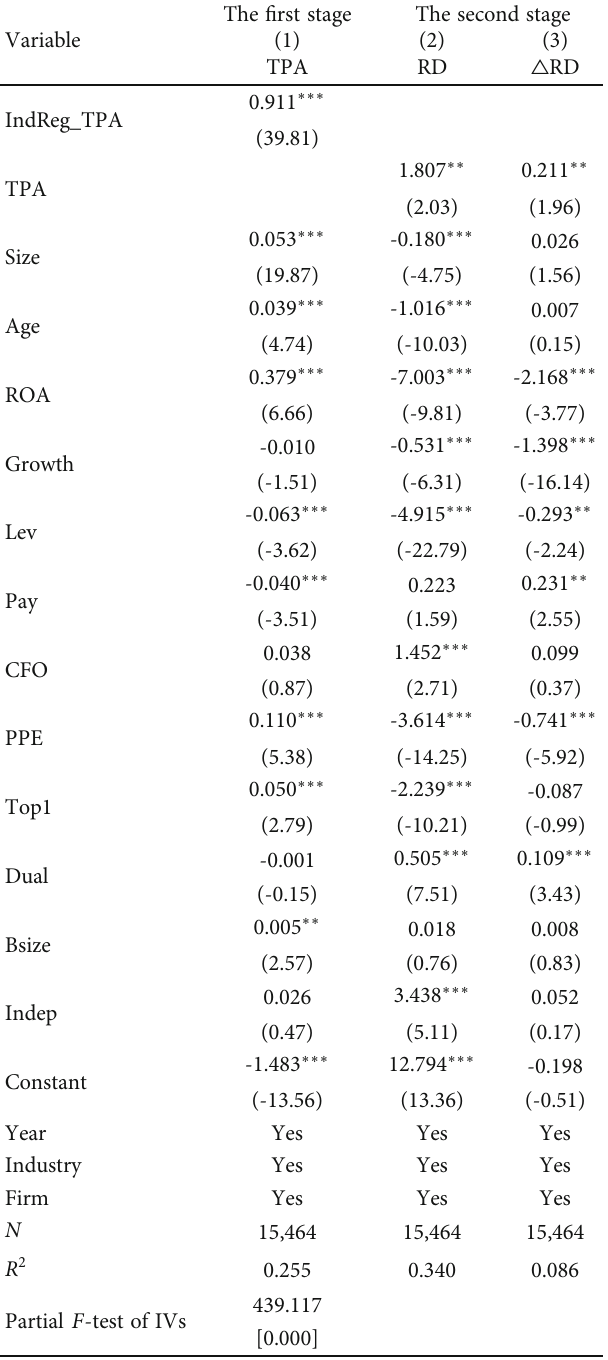
Table 6: Endogeneity